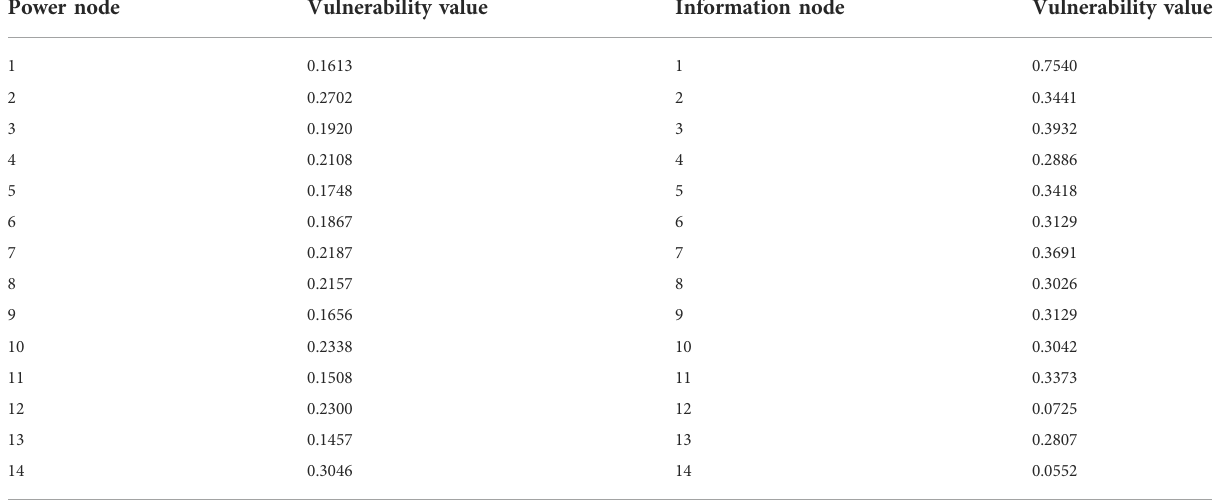
TABLE 4 Node vulnerability value of the power cyber-physical system.